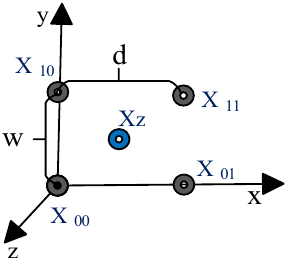
Figure 2. Location of the x z antenna.